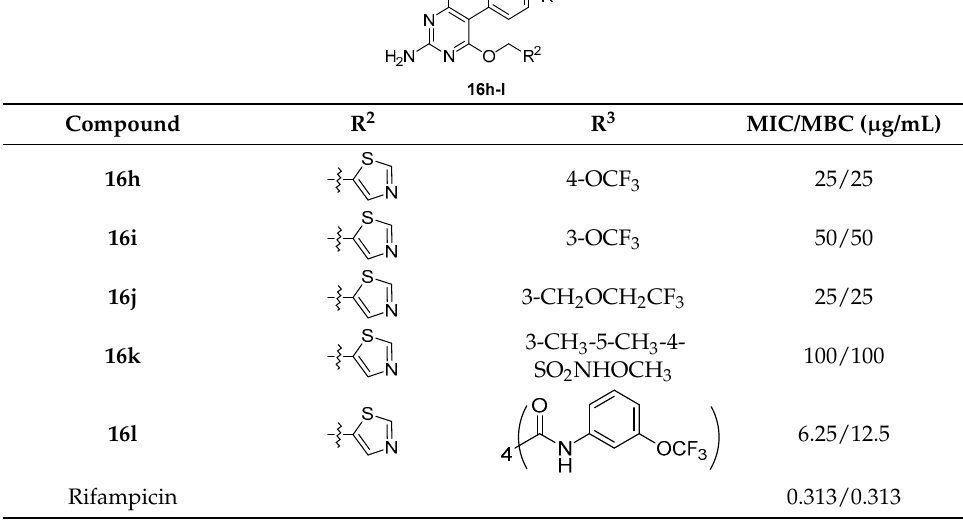
Table 1. Synthesis of 2,4-diamino-5-aryl-6-substituted pyrimidine derivatives 16a-p via Suzuki reactions.